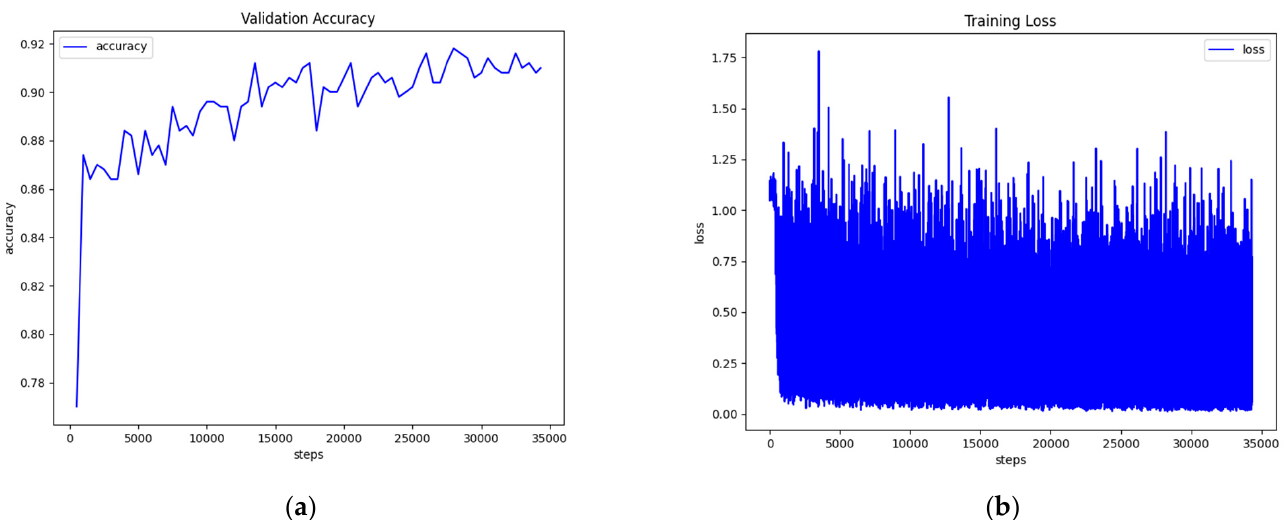
Figure 1. ( a ) Validation accuracy graph and ( b ) training loss graph of best model (RoBERTa-Large) for SNLI.